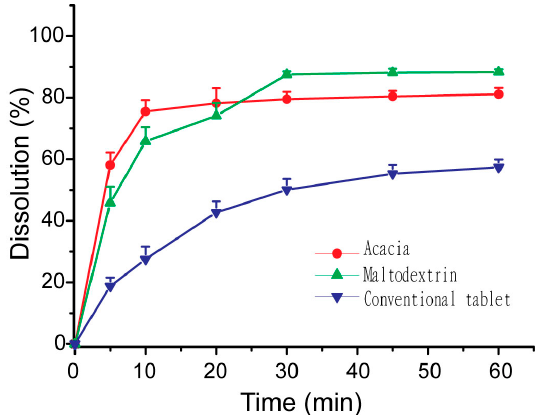
Figure 8. Dissolution profiles of nimodipine from S-SMEDDS with maltodextrin ( (cid:78) ), S-SMEDDS with acacia ( (cid:108) ) and the conventional tablet ( (cid:72) ) in pH 4.5 acetate bu ff er containing 0.05% ( w / v ) of sodium dodecyl sulfate. Data were expressed as mean ± S.D. ( n = 6).